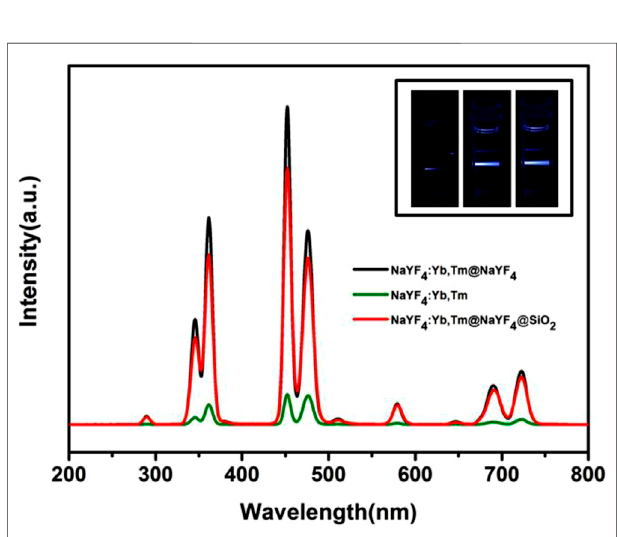
FIGURE 2 | Luminescence analysis of NaYF 4 :Tm,Yb (green), NaYF 4 : Tm,Yb@NaYF 4 @SiO 2 (red), and NaYF 4 :Tm,Yb@NaYF 4 (black). The corresponding fl uorescent photographs are shown in the inset images from the left to right. All samples at 1 mg/ml were used in the